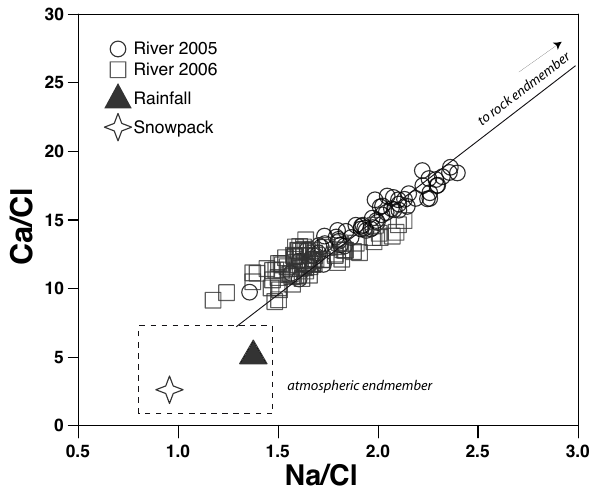
Fig. 10. Mixing diagram showing that the water samples from Urumqui River can been seen as a mixing between two endmem- bers: precipitation and water derived from a water/rock interaction within the drainage basin. Elemental ratios are not sensitive to evap- oration processes. Note that 3 unexplained outlying points out of 134 are not shown on the figure but are available in the dataset. Table 2. Minimun and maximum ratios of the chemical element concentrations normalize to Cl − both in the rainfall (Zhao et al., 2008) and the Urumqi River (this